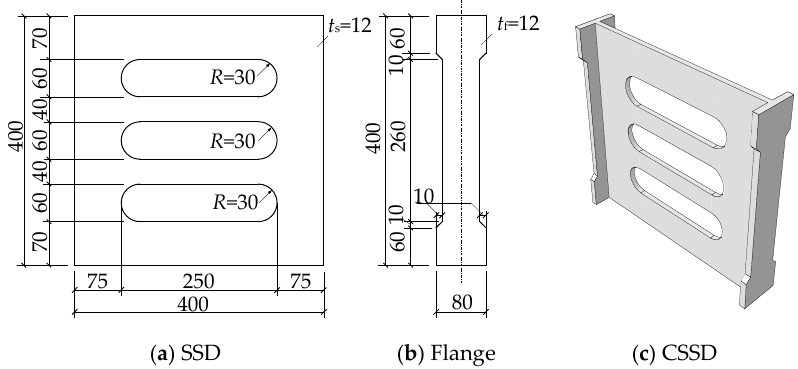
Figure 6. Configuration of the combined soft steel dampers (CSSD) device (all dimensions in mm): ( a ) soft steel damper (SSD); ( b ) flange; ( c ) CSSD device. Table 6. Material properties of the CSSD device in this study. Material Types.